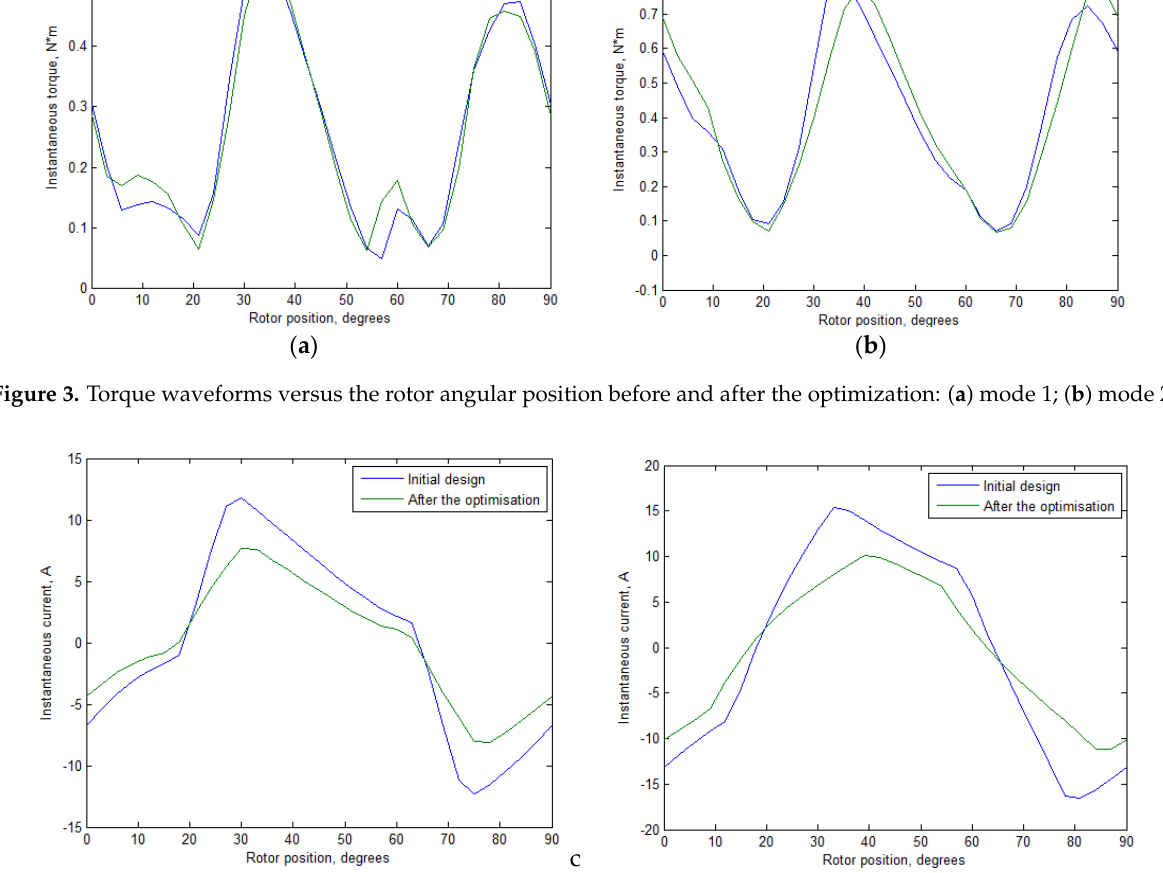
Figure 4. Current waveforms versus the rotor angular position before and after the optimization: ( a ) mode 1; ( b ) mode 2.